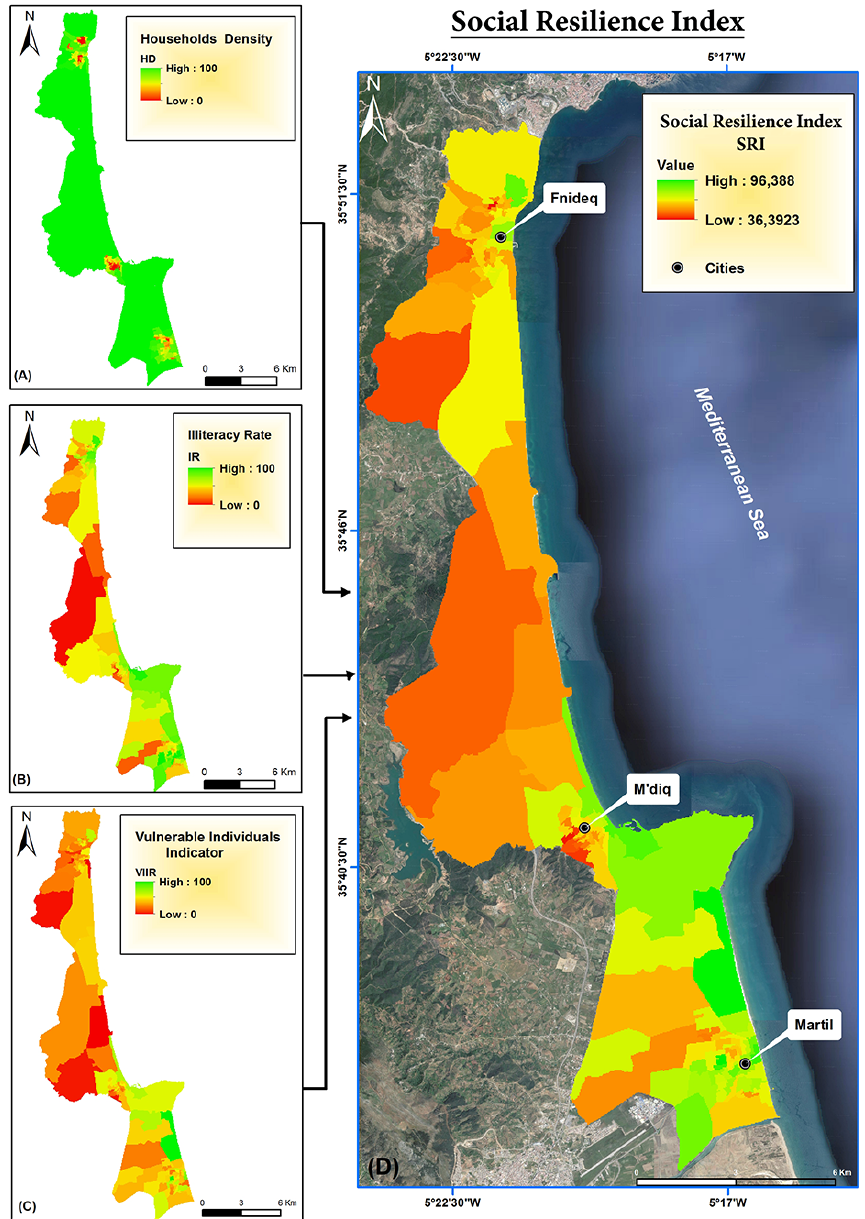
Figure 3. Spatial distribution of (a) household density, (b) illiteracy rate, (c) vulnerable-individual indicator, and (d) social-resilience index (obtained from © Google Maps